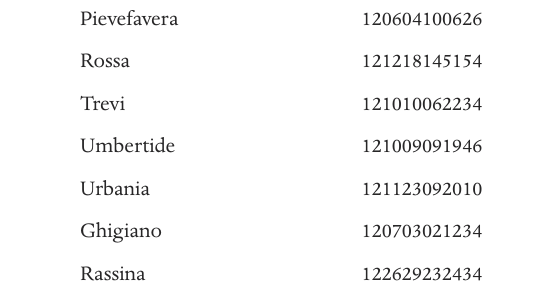
Figure 14. Cumulative number of events as a function of magnitude for the area depicted in Figure 13, and relevant b-values. (a) Whole cat- alogue. (b) Quarry blasts. (c) Tectonic